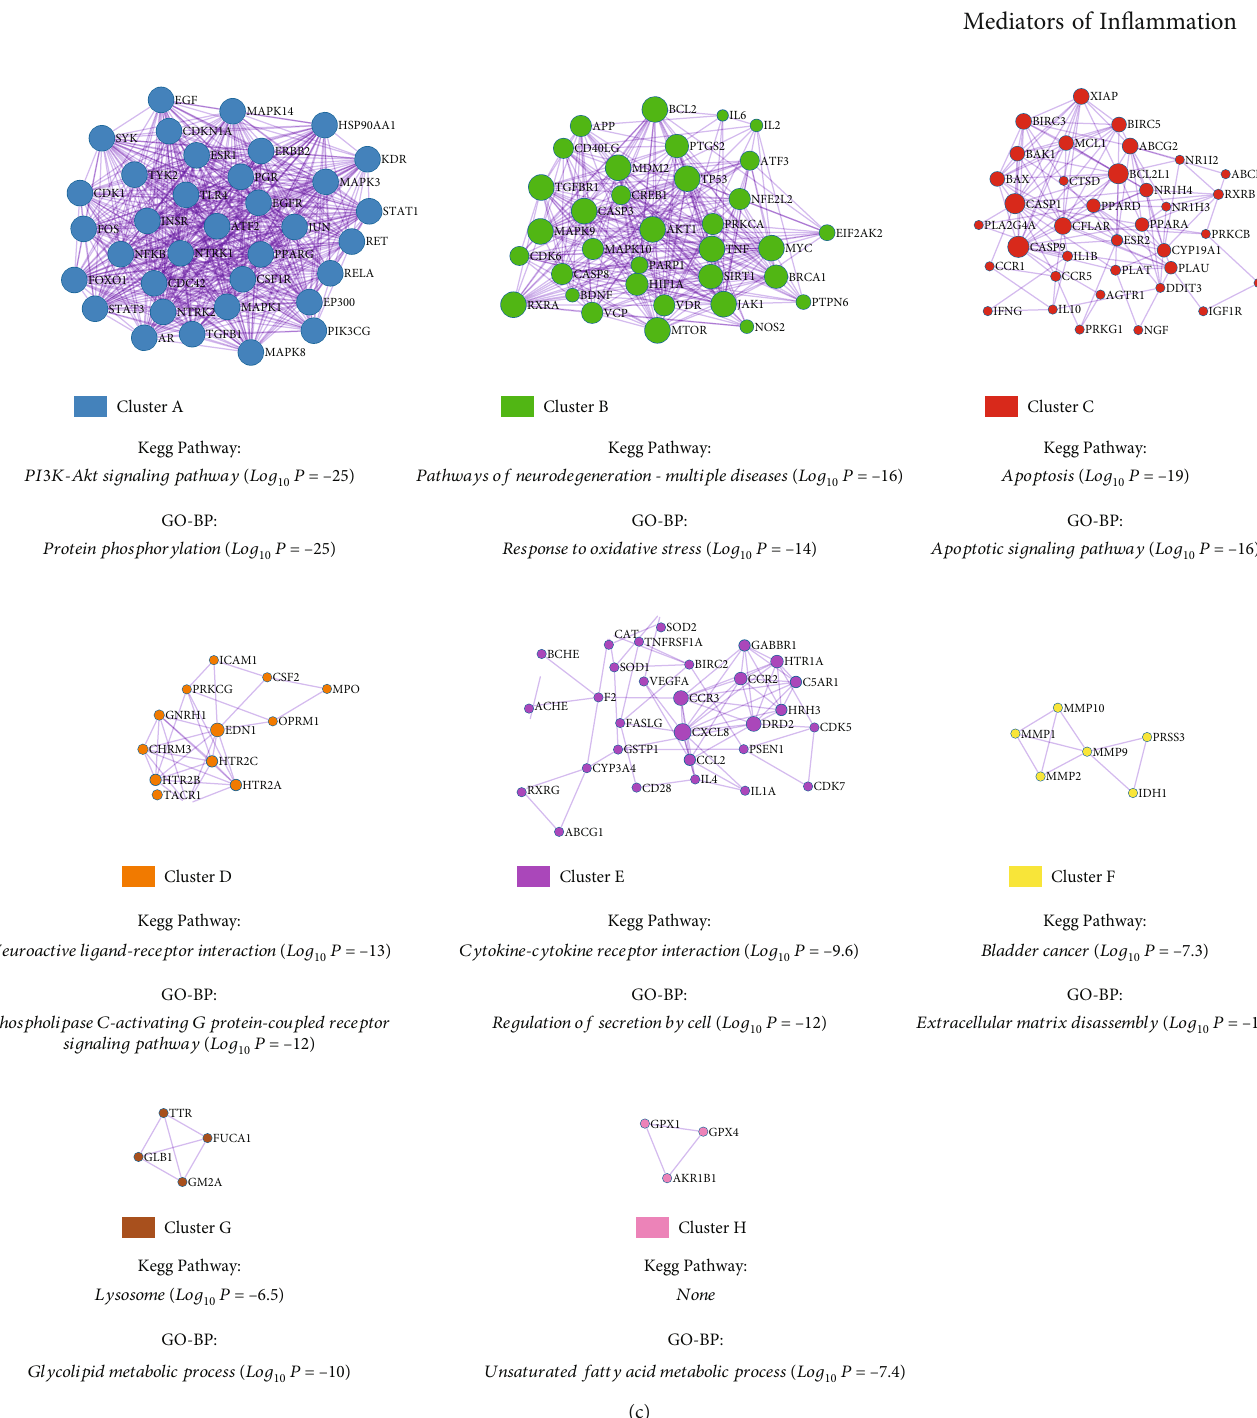
Figure 3: Protein-protein interaction (PPI) network of common targets between BSYS Capsule and CNSD. (a) PPI network and (b) the top 10 signi fi cant genes in the PPI network. (c) Eight clusters with the corresponding description from the PPI